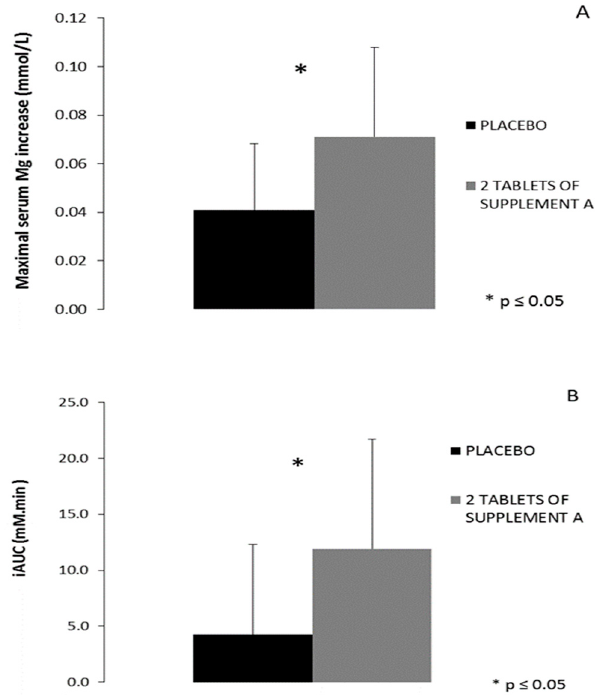
Figure 5. ( A ) The difference in serum magnesium concentration between the peak value and the concentration before ingestion of two tablets of either the placebo or Supplement A (* p = 0.05). ( B ) The incremental area under the curve (iAUC) of the serum magnesium concentration starting from 60’ before ingestion of the supplement or placebo (fasted sample) up to six hours after ingestion (* p = 0.02).